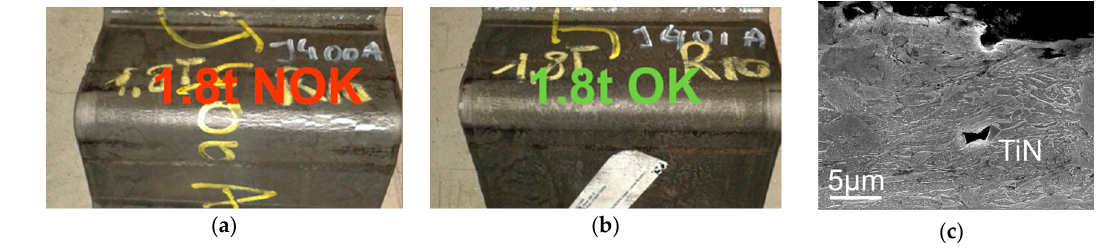
Figure 10. Effect of N on the bending behavior, 90° V-bending, r / t = 1.8 ( a ) DQ3 steel, high N; ( b ) DQ3 steel, low N; ( c ) Damage around a coarse TiN particle in DQ1 steel.